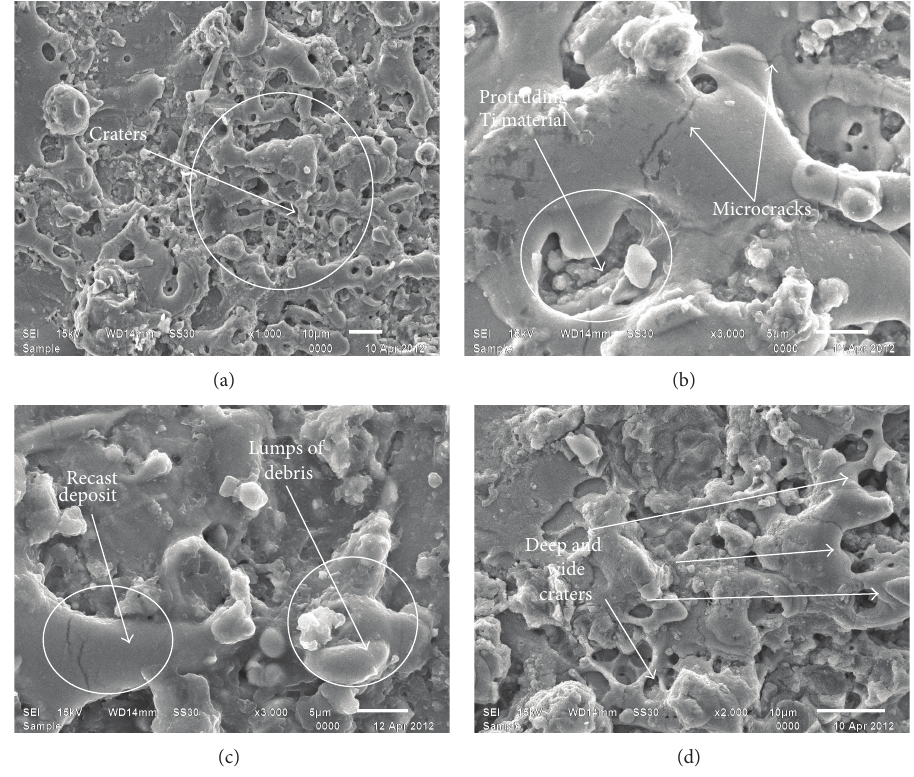
Figure 6: SEM micrograph (1000x, 2000x, 3000x, and 500x): (a) experiment no. 1, at 𝑇 on = 1.1 𝜇 s, 𝑇 off = 28𝜇 s, Ip = 200 A, SV = 50V, WF = 7m/min, WT = 500 grams; (b) experiment no. 52, at 𝑇 on = 1.1 𝜇 s, 𝑇 off = 28 𝜇 s, Ip = 200 A, SV = 50 V, WF = 7 m/min, WT = 1400 grams; (c) experiment no. 50, at 𝑇 on = 1.1 𝜇 s, 𝑇 off = 17 𝜇 s, Ip = 160A, SV = 60V, WF = 7m/min, WT = 950 grams; (d) experiment no. 36, at 𝑇 on = 0.9 𝜇 s, 𝜇 s, Ip = 200 A, SV = 50 V, WF = 10m/min, WT = 950 𝑇 off = 17